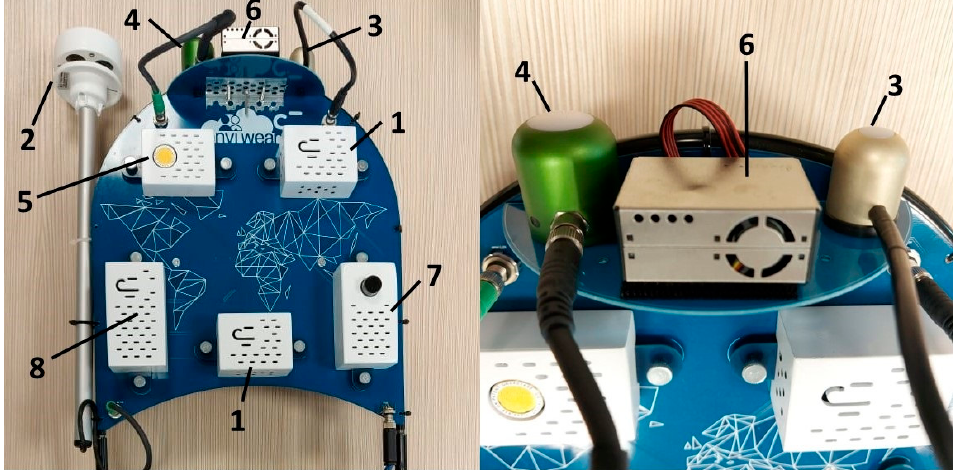
Figure 4. Sensors in the wearable equipment. Table 1. Technical specifications of each sensor in the new wearable monitoring equipment.